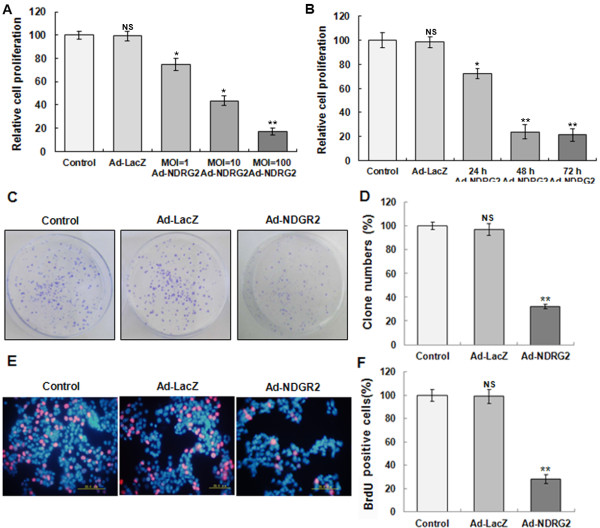
Up-regulating NDRG2 inhibits Eca-109 cell growth. A. Dose-dependent suppression of Eca-109 cell proliferation by Ad-NDRG2. Eca-109 cells were infected with various amounts of Ad-NDRG2 or Ad-LacZ (at MOI of 1, 10, and 100) and incubated for 48 h. Cell proliferation was detected by MTT assay. B. Time-dependent suppression of Eca-109 cell proliferation by Ad-NDRG2. After Ad-NDRG2 or Ad-LacZ infection at an MOI of 100, the cells were incubated for different time periods (24, 48 and 72 h). Cell proliferation was detected by MTT assay. C and D. The effect of Ad-NDRG2 on Eca-109 cell colony formation was examined. After Ad-NDRG2 or Ad-LacZ infection, the cells were incubated for approximately 10 days until visible cell colony formation. Only the clearly visible colonies (diameter > 50 μm) were counted. E and F. The effect of Ad-NDRG2 on Eca-109 cell DNA replication activity was examined. After Ad-NDRG2 or Ad-LacZ infection, the cells were incubated for 2 days and cultured with BrdU for 1 h and DAPI for nuclear counterstaining. The results were analysed using a fluorescence microscope; BrdU positive (red) cells were counted. Data are mean ± SD from three independent experiments. Statistical significance was assessed using a one-way ANOVA and Student’s t-test. * or ** indicates P < 0.05 or P < 0.01, respectively, compared to the control.